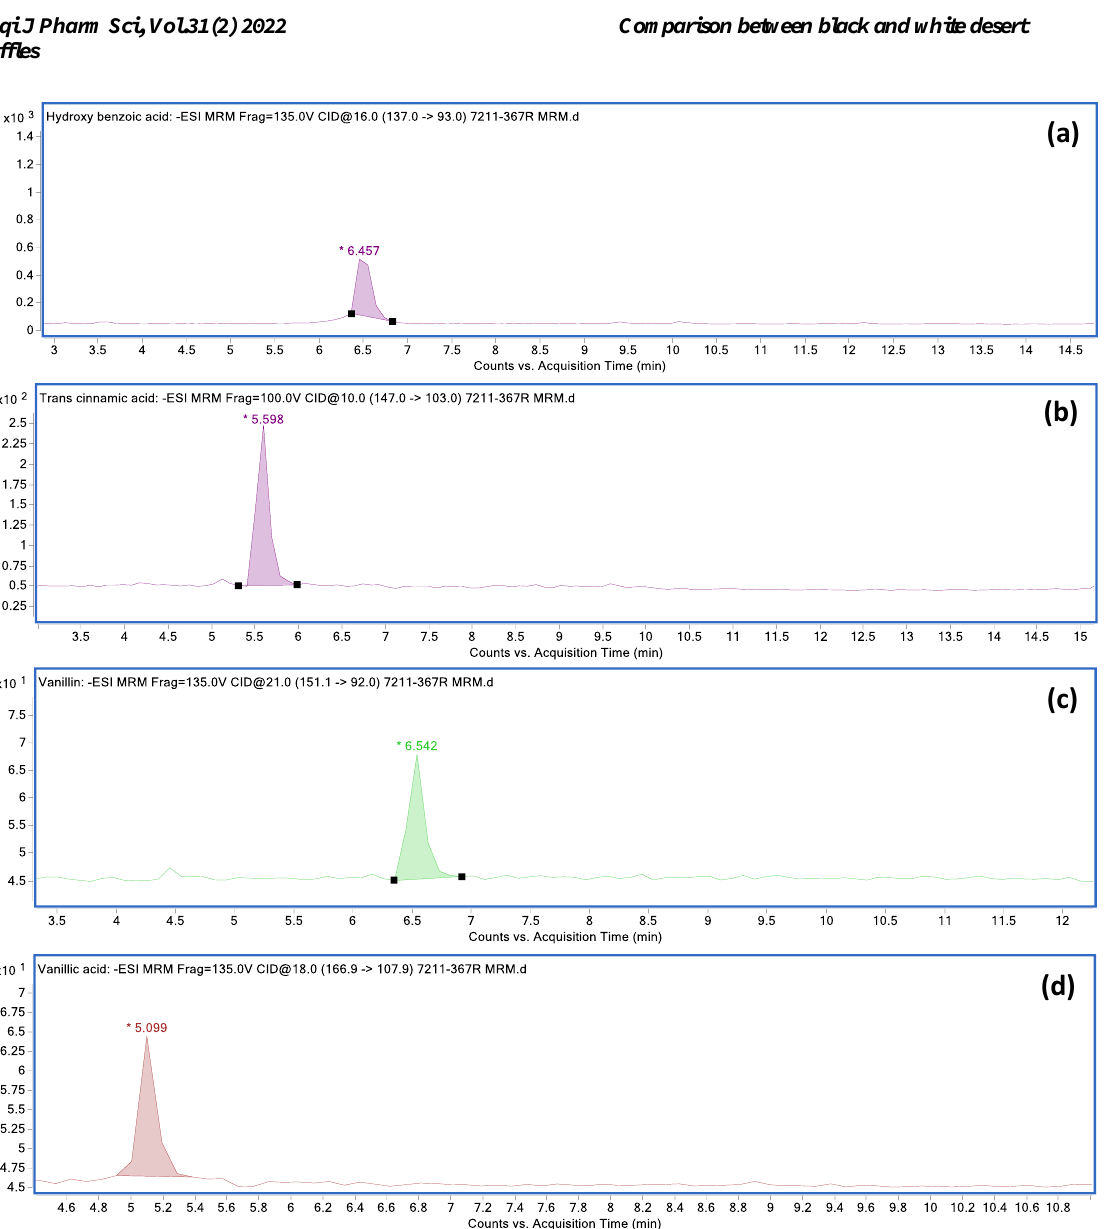
Figure 5.Chromatograms of some phenolics in ethanolic 70% extract of T.claveryi by LC-MS/MS. Where (a): Hydroxy benzoic acid, (b): Trans -cinnamic acid, (c): Vanillin, (d): Vanillic